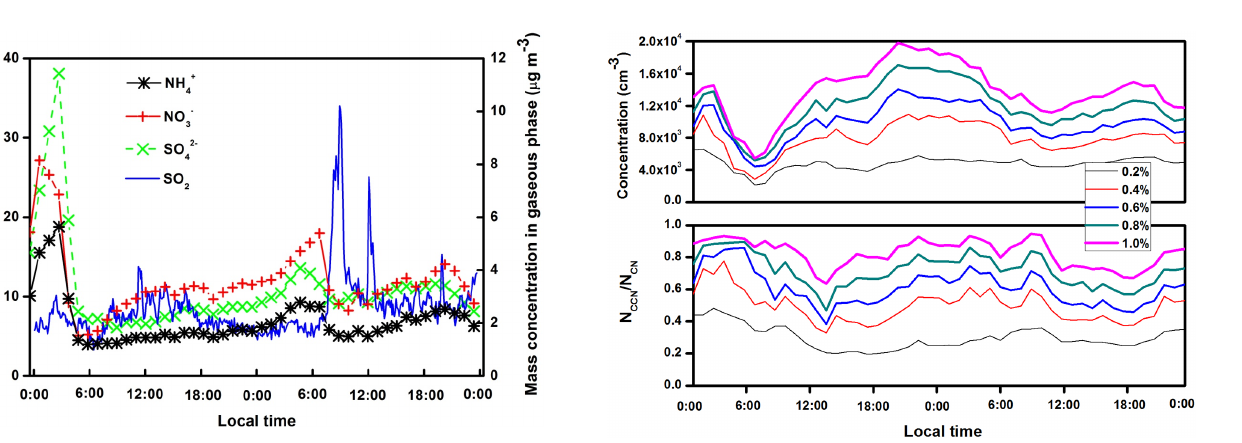
Figure 8. Series of 1h mean SO 2 , SO 2 − trations on 3 and 4 April 2012.